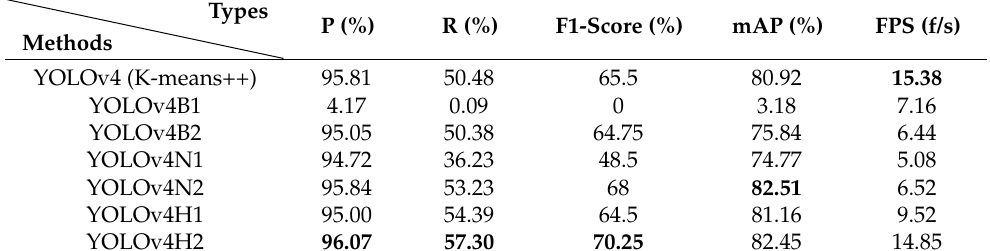
Table 2. Comparison of six models with different attention modules.